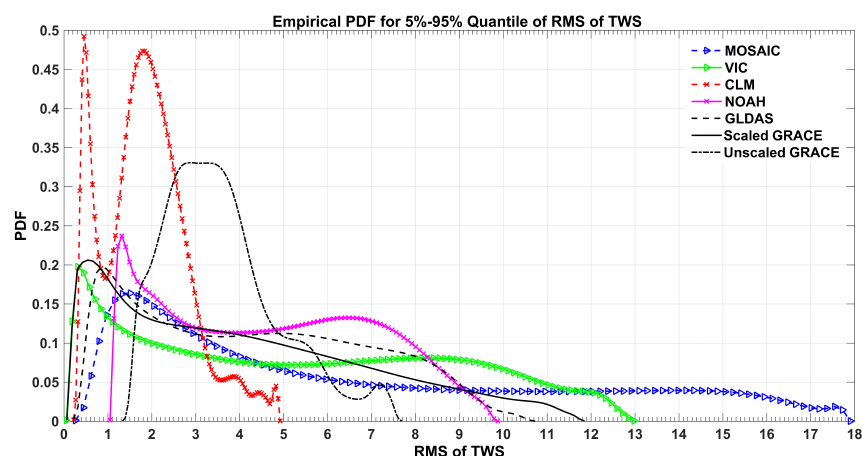
Figure 2. Empirical probability density distributions of root-mean-square of TWS from the scaled GRACE data, the unscaled GRACE data, and model simulations (only TWS values between the 5th and 95th quantiles are considered); unit of RMS is centimeters.